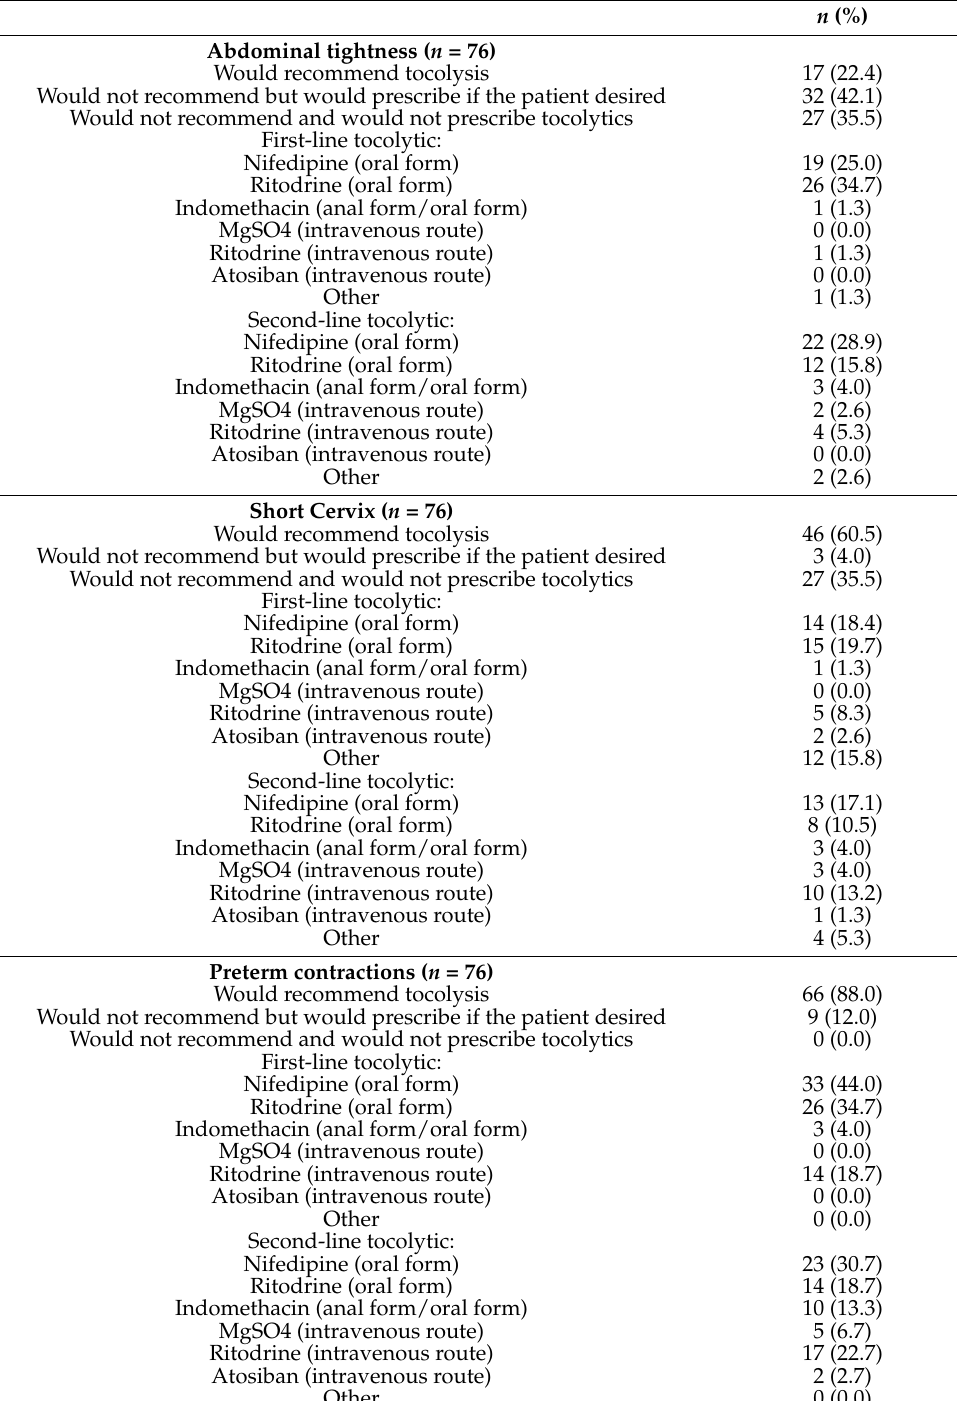
Table 3. Respondents’ use of